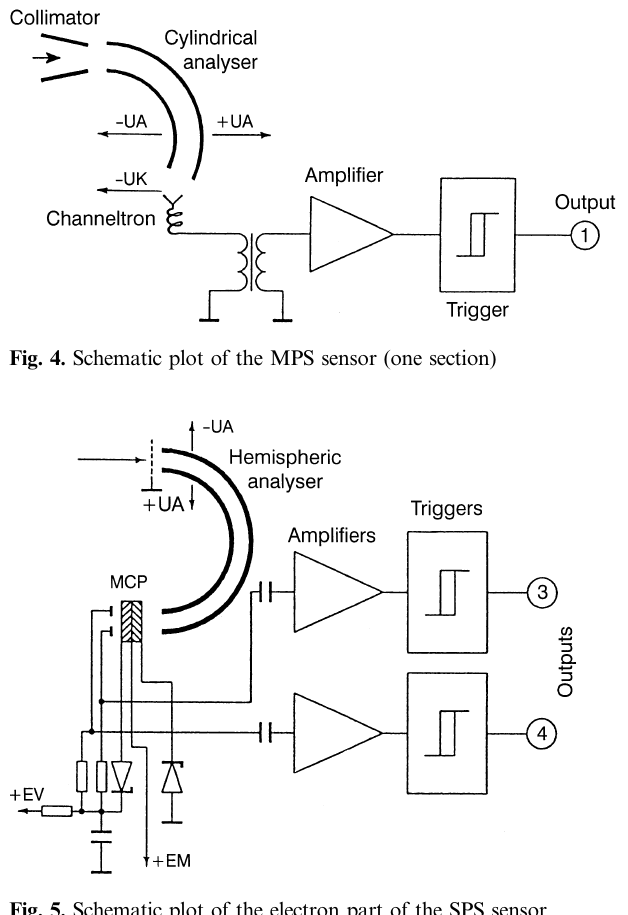
Fig. 5. Schematic plot of the electron part of the SPS